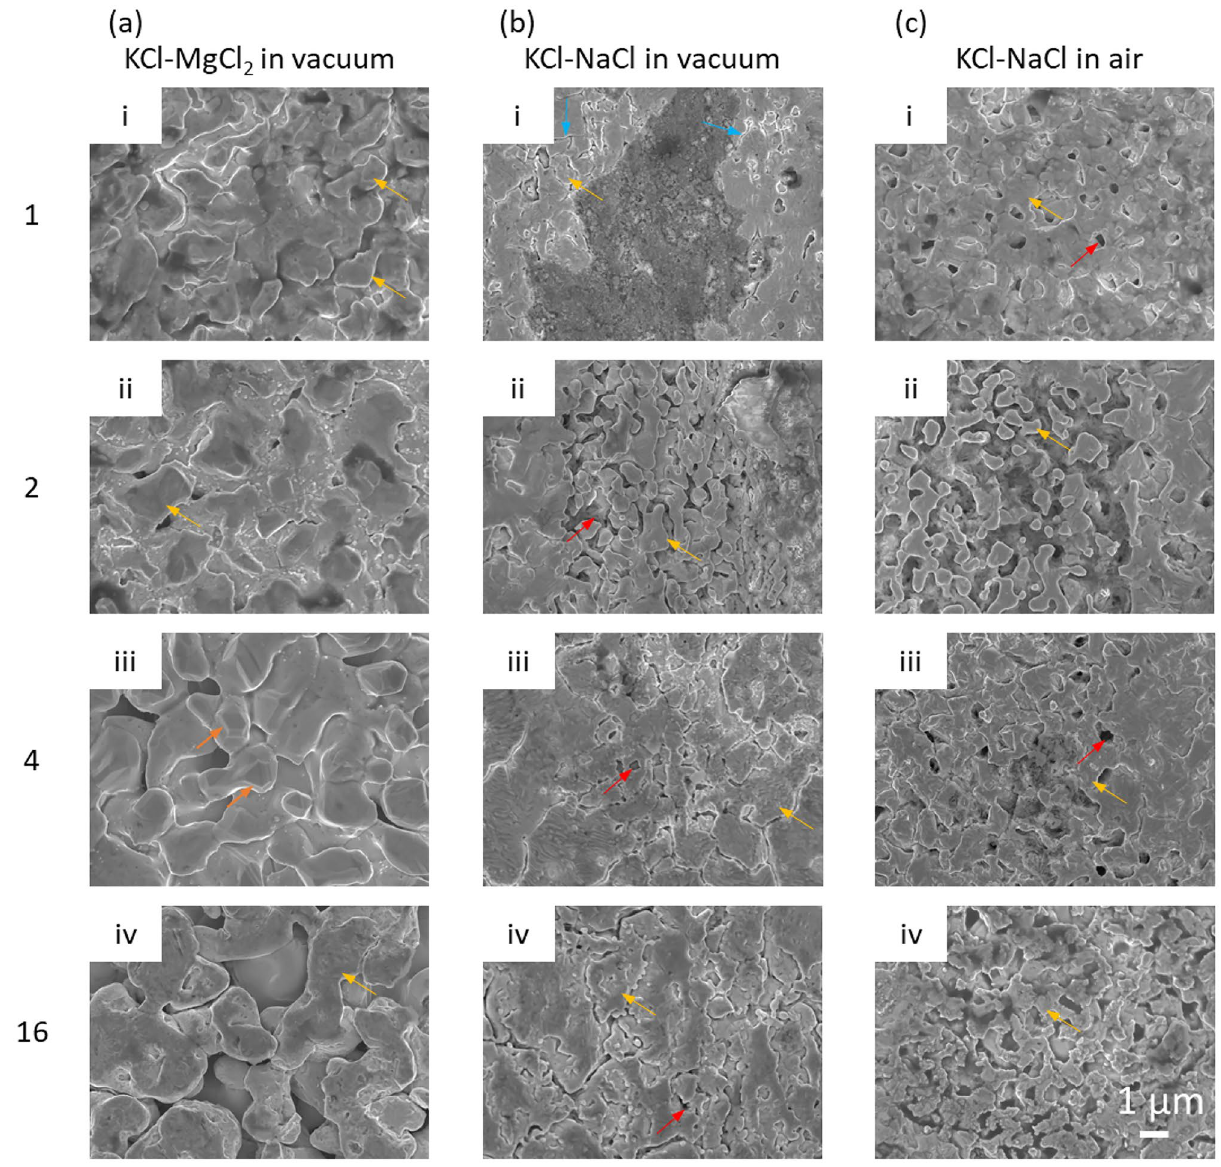
Figure 1. SEM images showing the surface morphology of Ni–20Cr alloy corrosion in molten salts under different conditions: ( a ) KCl–MgCl 2 in vacuum, ( b ) KCl–NaCl in vacuum, and ( c ) KCl–NaCl in air for (i) 1 h, (ii) 2 h, (iii) 4 h, and (iv) 16 h. The orange arrows indicate the facets formed on the surface after corrosion. The blue arrows indicate the cracks, the red arrows show the pores, and the yellow arrows refer to the